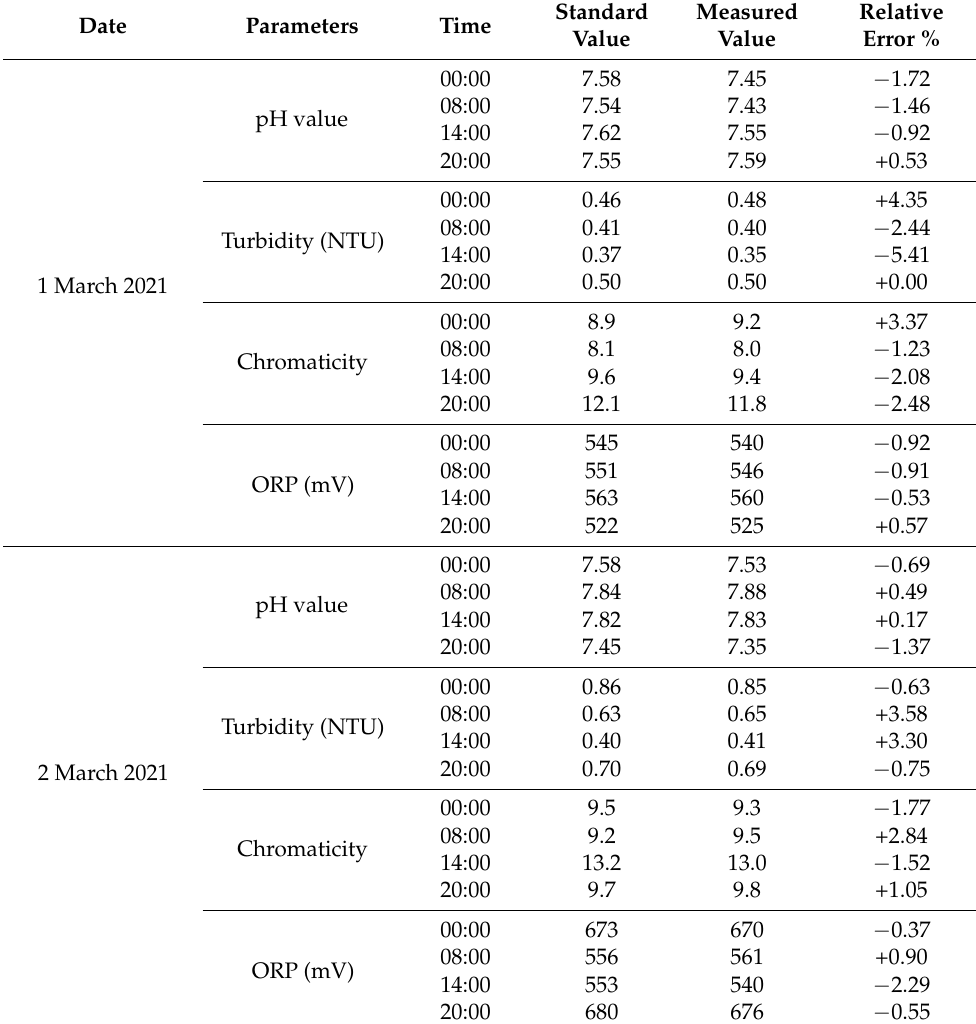
Table 2. Comparison of measured and standard value of water quality